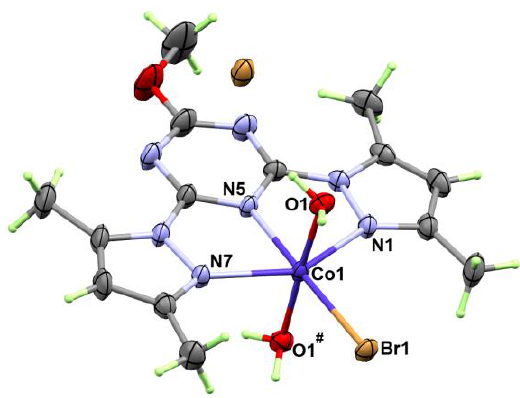
Figure 2. X-ray structure of 1 . Symmetry code for O1 # is x, 1.5 − y, z. Table 1. Crystal data and refinement details of 1 and ( L ). It acts as a tridentate N -chelate coordinated to the Co (II) ion via three Co–N s -triazine core. The corresponding Co–N distances are 2.211(5), 2.226(4), and 2.059(4) Å s -triazine complexes [32], the Co–N (triazine) is shorter than the Co–N (pyrazole) bonds